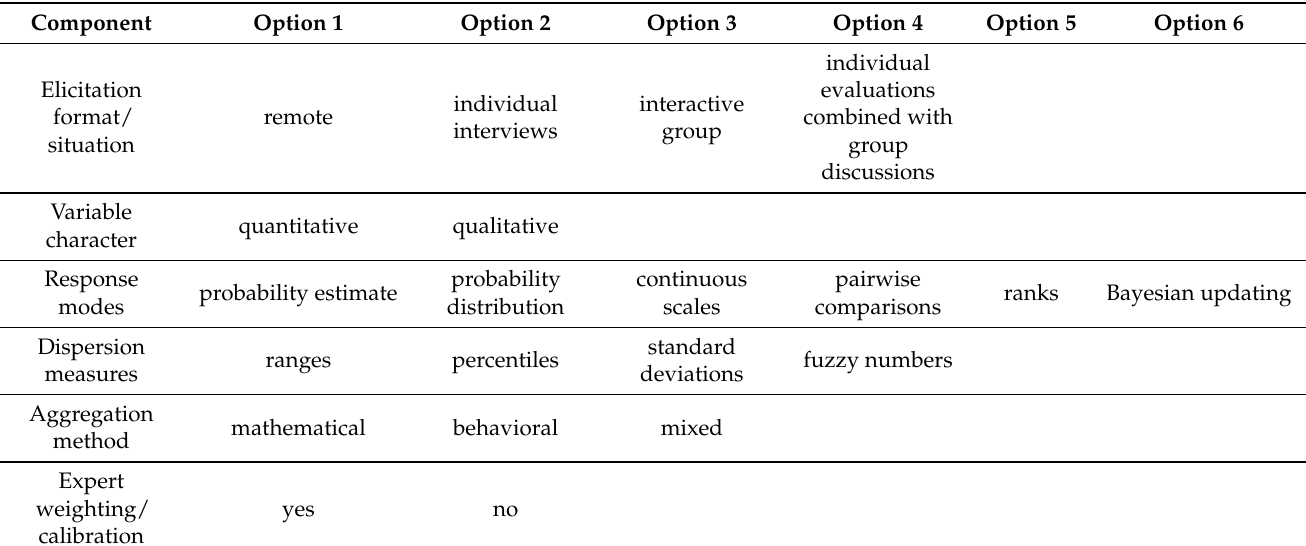
Table 1. Identified SEJE components and their implementation options in the form of a morphologi- cal